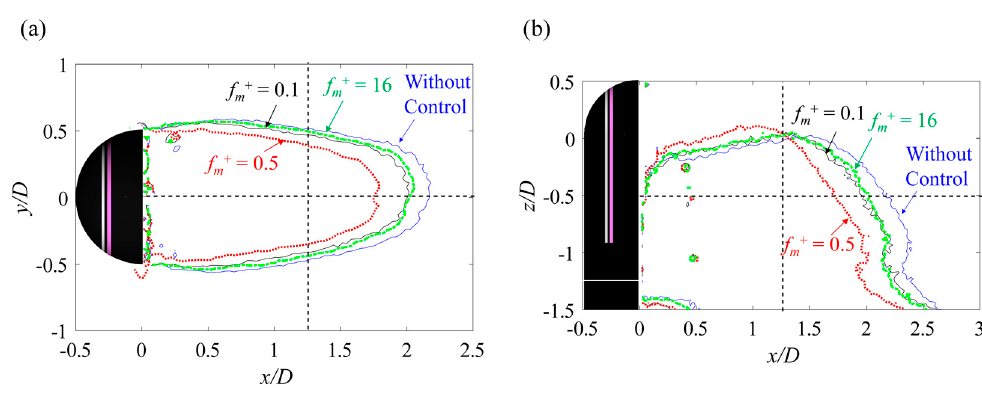
Figure 23. Contour lines of u / U ∞ = 0.0 in ( a ) the x – y cross section and ( b ) the x – z cross section.